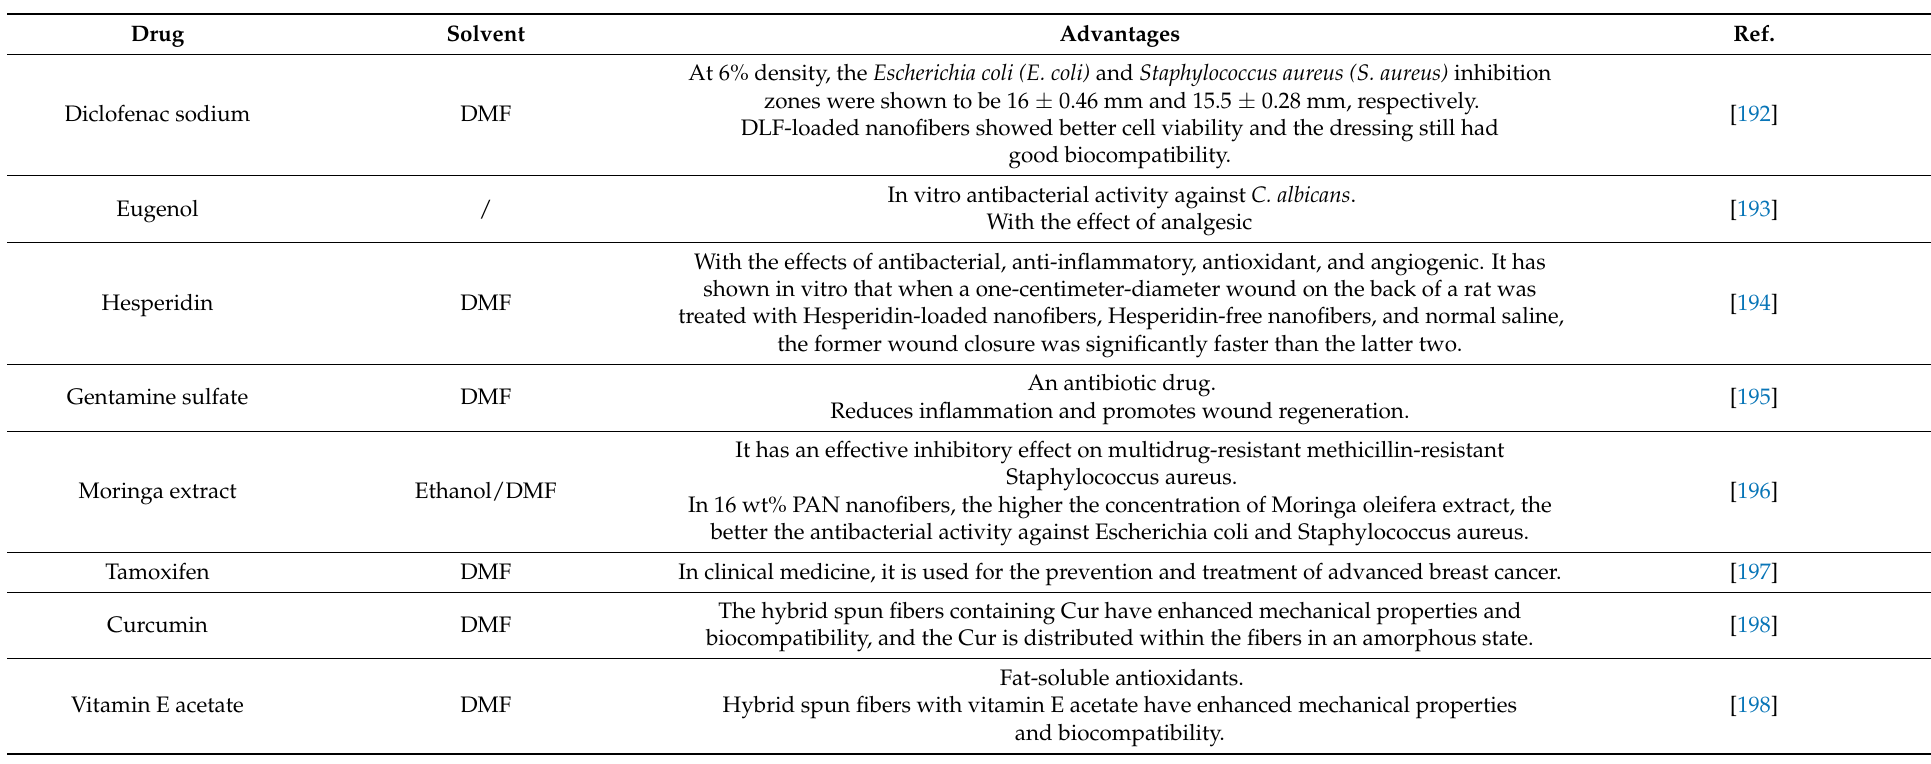
Table 2. Drugs used in PAN drug-loaded nanofiber wound